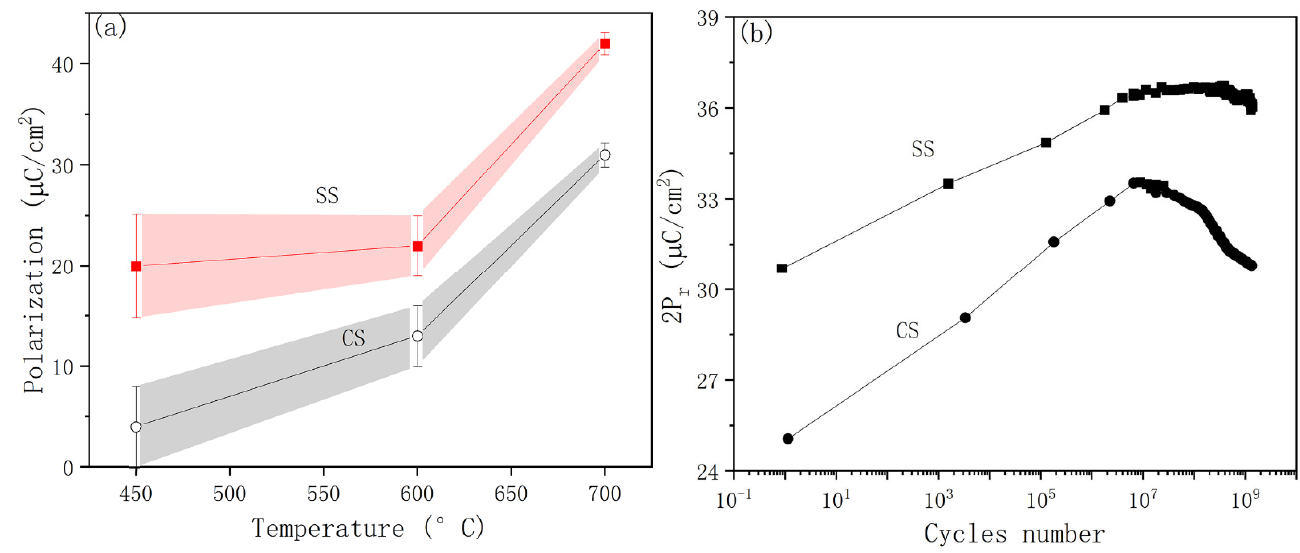
Figure 2. ( a ) Average statistical value of residual polarization for SS and CS samples at various temperatures. ( b ) Characteristics of endurance intensity with increasing number of continuous cycles at low temperature of 400 °C.